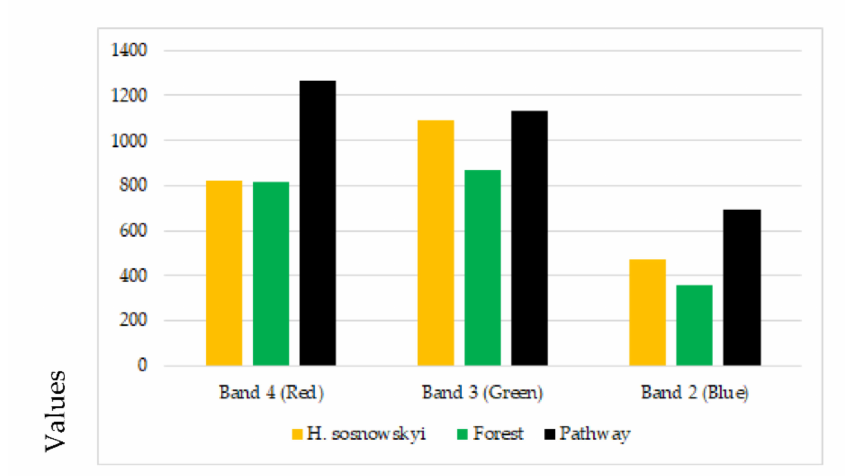
Figure 4. Results for crop classes based on spectral signature. A mean spectral signature of 956 for H. sosnowskyi was estimated based on supervised classification.